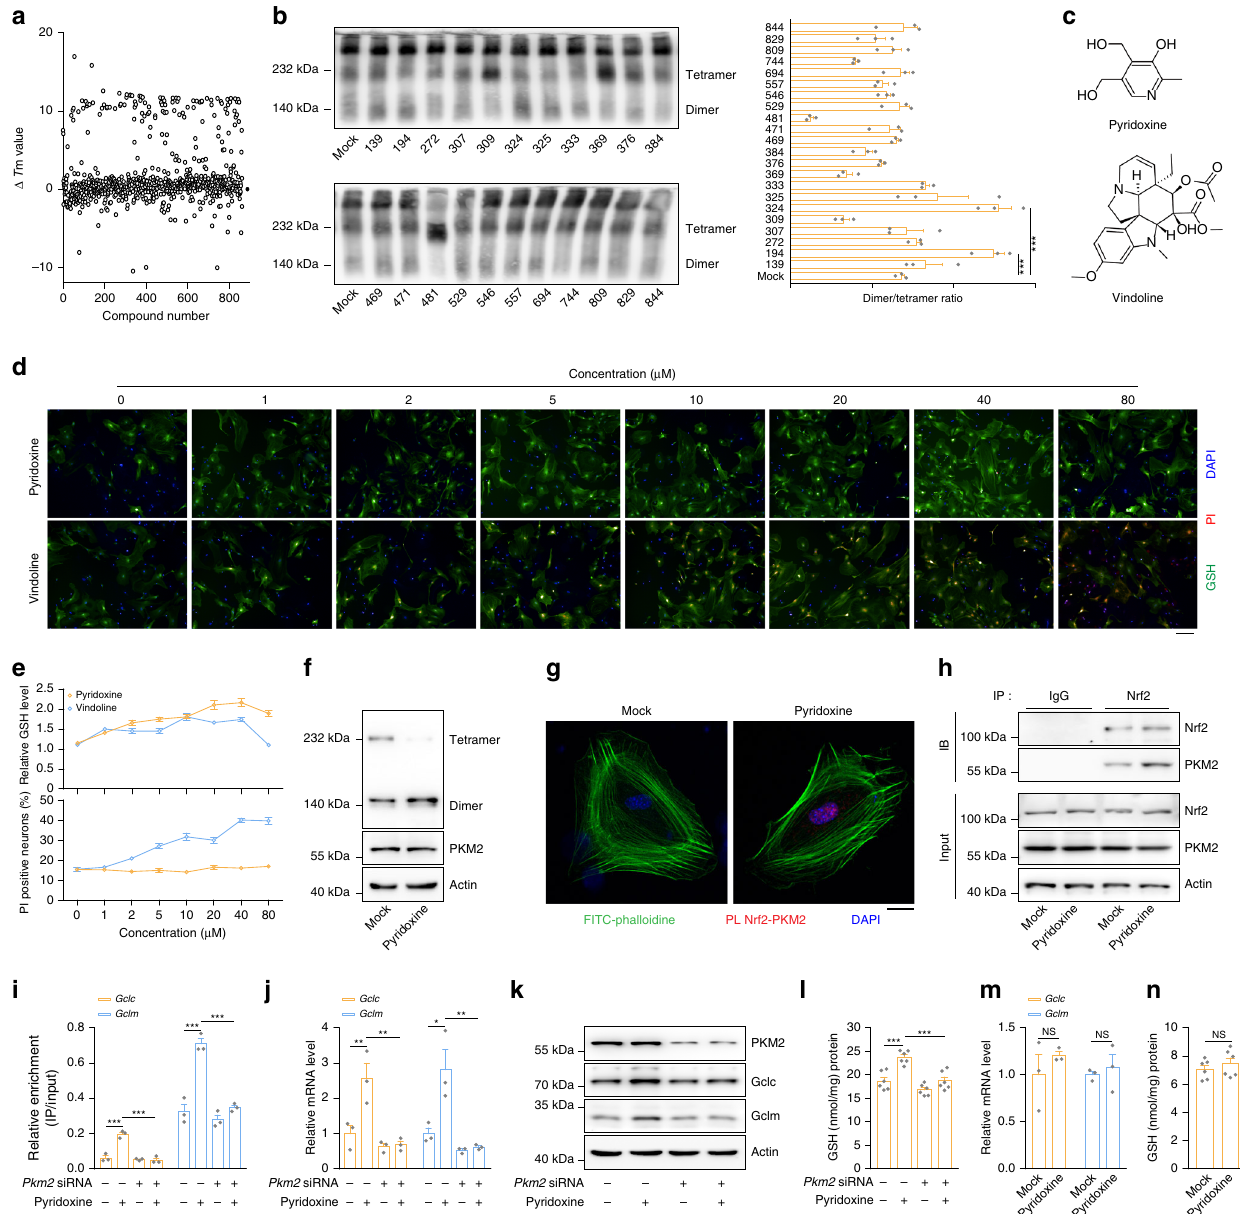
Fig. 5 Pyridoxine facilitates GSH synthesis via the PKM2-Nrf2 pathway. a , b Puri fi ed recombinant PKM2 (rPKM2) was mixed with 863 natural products individually. ▵ Tm values analyzed by NanoDSF ( a ). rPKM2 dimer and tetramer formation analyzed by BN-PAGE (left) and densitometric analysis of the dimer/tetramer ratio (right) ( b ). c Chemical structures of compound no. 194 (vindoline) and no. 324 (pyridoxine). d , e Primary astrocytes were stimulated with different concentrations of pyridoxine or vindoline for 12 h. Immuno fl uorescence of GSH and PI analyzed by high-content screening ( d ). The relative intensity of GSH signals (upper) and the percentage of PI-positive nuclei (lower) ( e ). Scale bar, 100 µ m. f – h Primary astrocytes were stimulated with 5 µ M pyridoxine for 12 h. PKM2 dimer and tetramer formation analyzed by BN-PAGE and total PKM2 detected by immunoblotting with actin as a loading control ( f ). PKM2 and Nrf2 proximity ligation signals ( g ). Immunoblot analysis of PKM2 in cell lysates immunoprecipitated with a Nrf2 antibody ( h ). Immunoblotting: three independent experiments. Scale bar, 10 µ m. i – l Primary astrocytes transfected with Pkm2 -speci fi c siRNA were stimulated with 5 µ M pyridoxine for 12 h. The amount of anti-Nrf2-immunoprecipitated DNA analyzed by qRT-PCR with primers fl anking the Gclc and Gclm promoter regions ( i ). Gclc and Gclm mRNA detected by qRT-PCR ( j ). Immunoblotting with actin as a loading control ( k ) and GSH levels ( l ). Immunoblotting and qRT-PCR: three independent experiments; GSH assay: six independent experiments. m , n Primary neurons were stimulated with 5 µ M pyridoxine for 12 h. Gclc and Gclm mRNA detected by qRT-PCR (m) and GSH levels ( n ). qRT-PCR: three independent experiments; GSH assay: six independent experiments. Data are presented as the mean ± s.e.m. * P < 0.05, ** P < 0.01, *** P < 0.001, NS, not signi fi cant. One-way ANOVA with Dunnett ’ s multiple comparisons test ( b ) or with Tukey ’ s multiple comparisons test ( i , j and l ). Student ’ s two-tailed unpaired t -test ( m , n ). Source data are provided as a Source Data fi